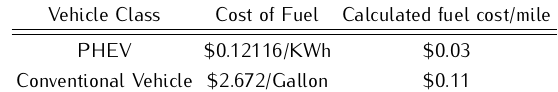
Table 1. Calculation of fuel cost/mile